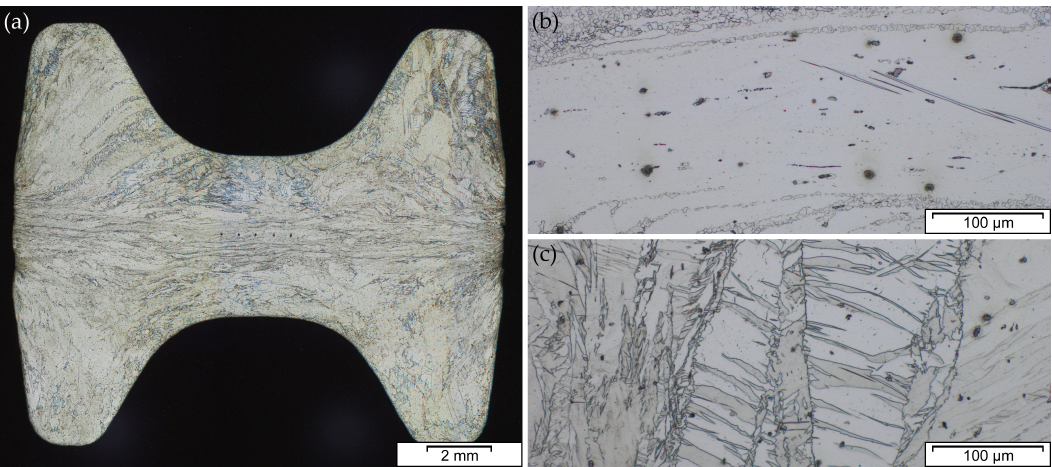
Figure 4. Microstructure of an AZ31 variation (AZ31 containing 0.3wt.%Ca and 0.2wt.%Y) in as-forged condition, formed at 425 ◦ C stock temperature and 280 ◦ C die temperature at a ram speed of 10mms − 1 , showing ( a )cross-section of forged part, ( b )sample center, ( c )sample